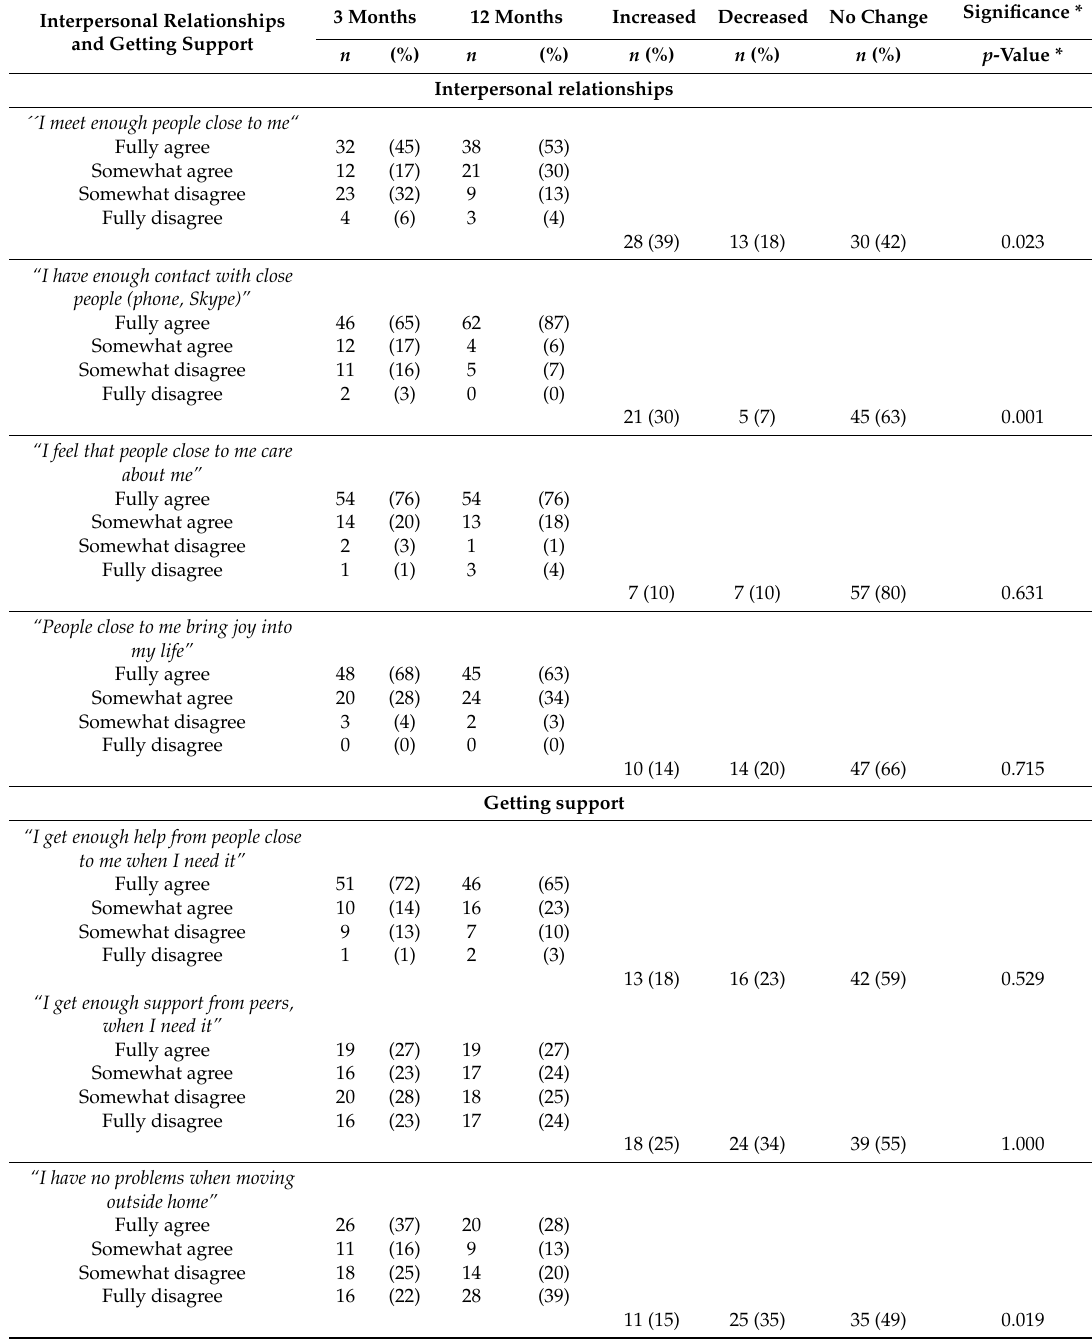
Table 3. Self-reported interpersonal relationships and getting support and changes in these variables 3 and 12 months after relocation to senior